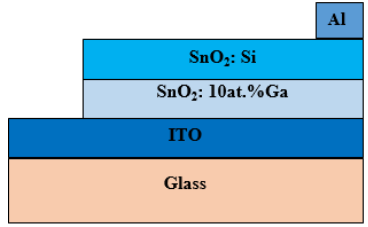
Figure 1. Schematic structure of the PN junction.